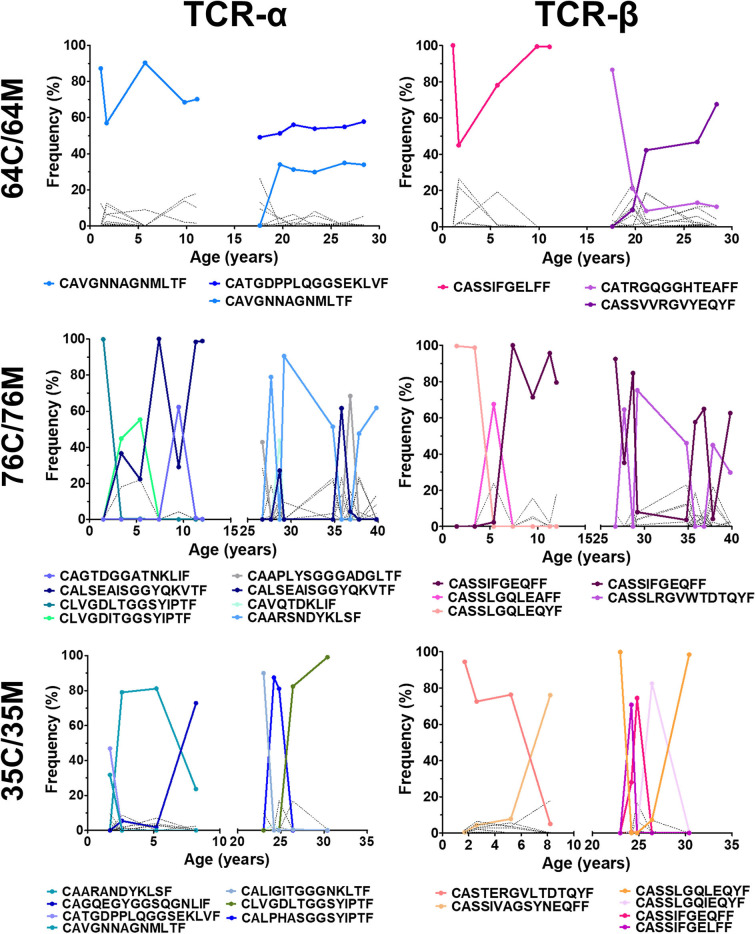
Clonotypic TCR superdominance is maintained in children and adults over time. The frequency of TCR-α (left) and TCR-β (right) is shown for three mother-child pairs monitored between 2005 and 2017. Superdominant clonotypes for each subject are shown in solid coloured lines. All other clonotypes are represented by solid black lines. A clonotype is considered superdominant if its frequency exceeds >30% at any point.